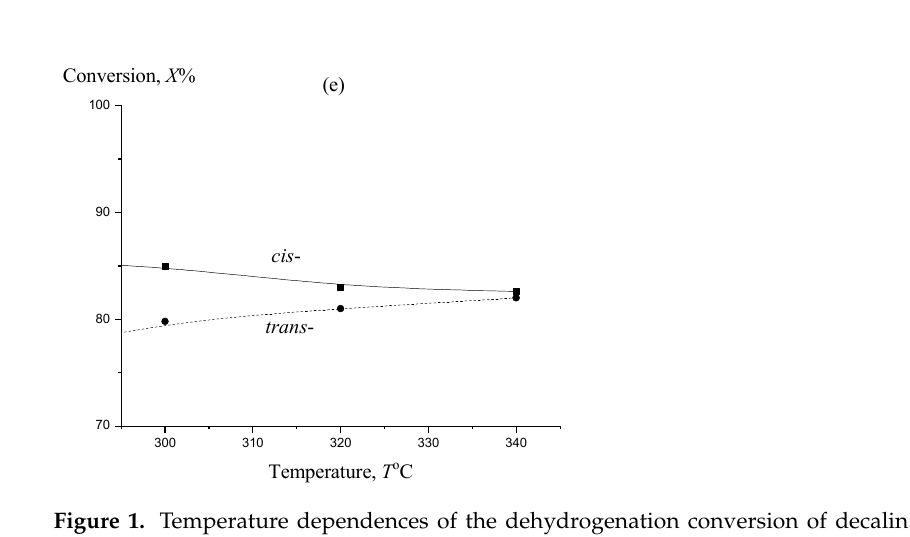
Figure 1. Temperature dependences of the dehydrogenation conversion of decalin: ( a ) bicyclohexyl; ( b ) perhydro- para -terphenyl; ( c ) perhydro- meta -terphenyl; ( d ) and perhydro- orto -terphenyl; ( e ) LHSV = 1 h − 1 , Р = 1 atm, t = 1 h.